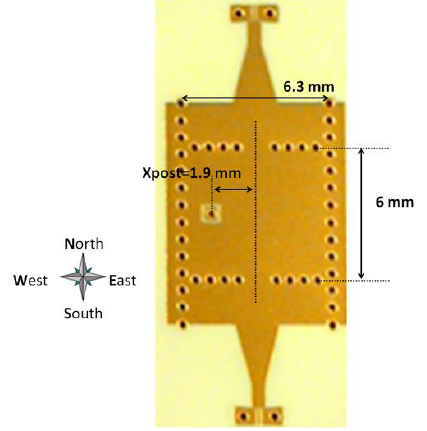
Figure 1. Photograph of a substrate integrated waveguide (SIW) cavity with tuning post and four wire bondings.